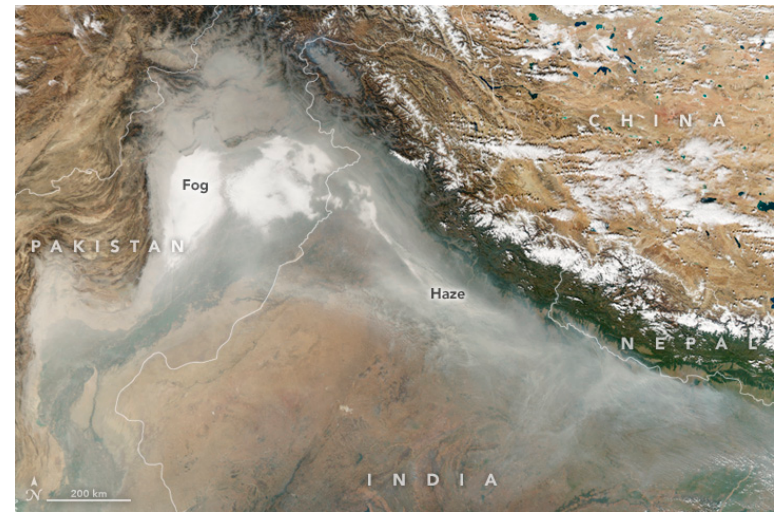
Figure 1. NASA Earth Observatory image of fog and haze distribution over the Northern States of India on 8 November 2017 [54].